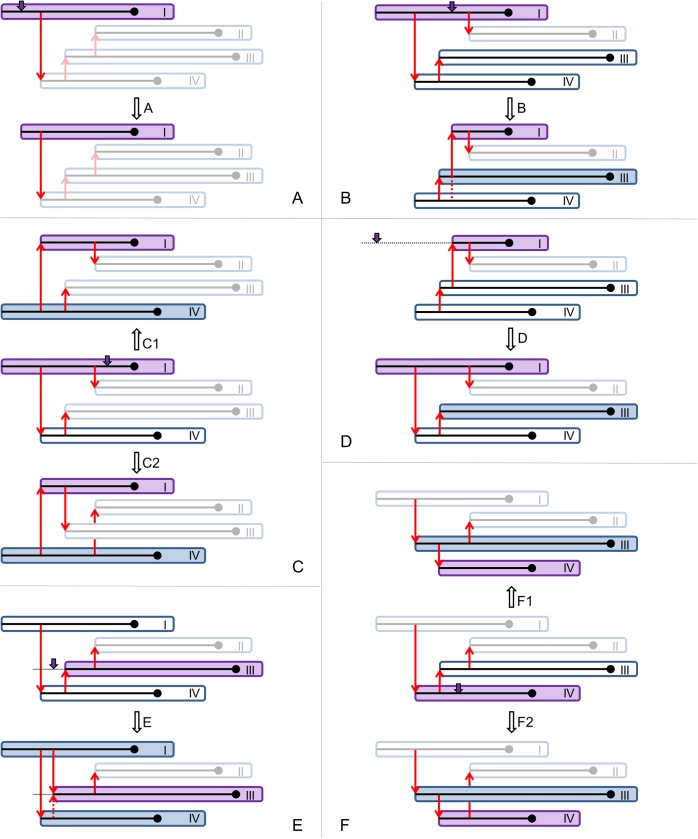
Graphics depicting proposal steps A-F for new transmission and phylogenetic trees. In panels A, B, D, and E, the initial situation is at the top, and the proposal below. In panels C and F, the initial situation is in the middle, and two alternative proposal above and below. Every panel shows an outbreak with four hosts, with red arrows indicating transmission: the purple host is the focal host, with the purple arrow indicating the proposal for the new infection time Ii’; filled hosts have a new phylogenetic mini-tree proposed; greyed-out hosts do not play a role in the proposal. (A) the focal host is the index case, and Ii’ is before the first transmission event; (B) the focal host is the index case, and Ii’ is after the first, but before the second secondary case; (C) the focal host is the index case and Ii’ is after his second secondary case; (D) the focal host is not the index case and Ii’ is before infection of the index case; (E) the focal host is not the index case and Ii’ is before his first secondary case; (F) the focal host is not the index case and Ii’ is after his first secondary case.